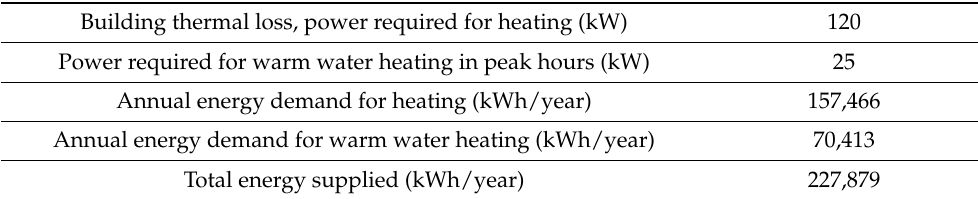
Table 5. Building energy